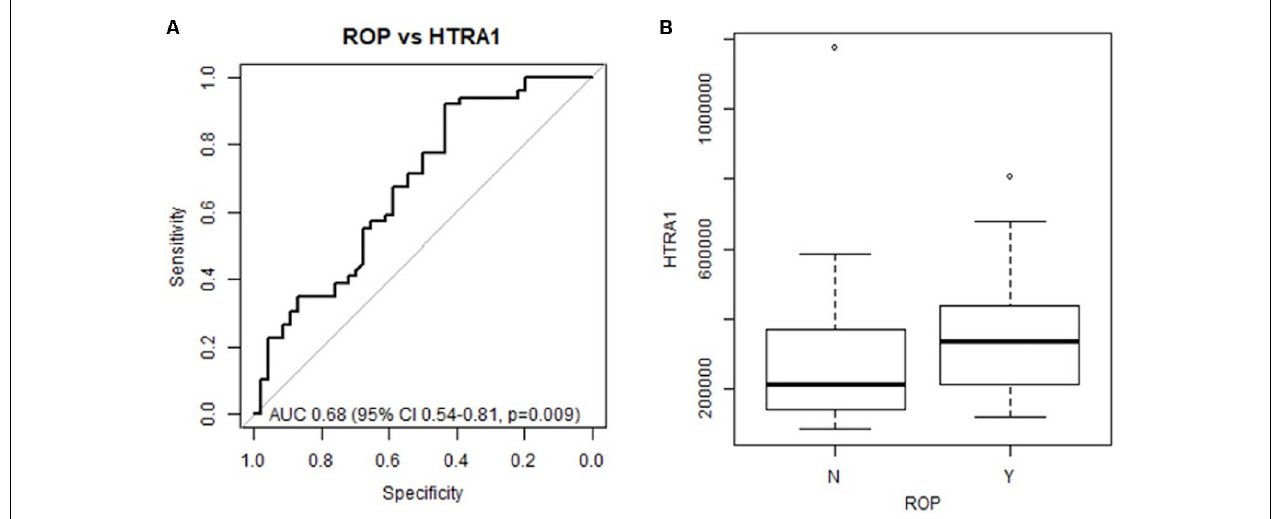
FIGURE 1 | Preterm infant HTRA-1 predicts subsequent retinopathy of prematurity (ROP) development in a dose-dependent fashion. HTRA-1 protein was measured using ELISA in preterm infant peripheral ( n = 140) and cord blood ( n = 36) samples. (A) The area under the receiver operating curve (AUC) demonstrates the significance of average HTRA-1 values for the prediction of ROP development ( p = 0.009). (B) Odds ratio analysis demonstrates an increase of 2.32 ROP risk for each doubling of systemic HTRA-1 expression (95% CI 1.03–5.24, p = 0.043).